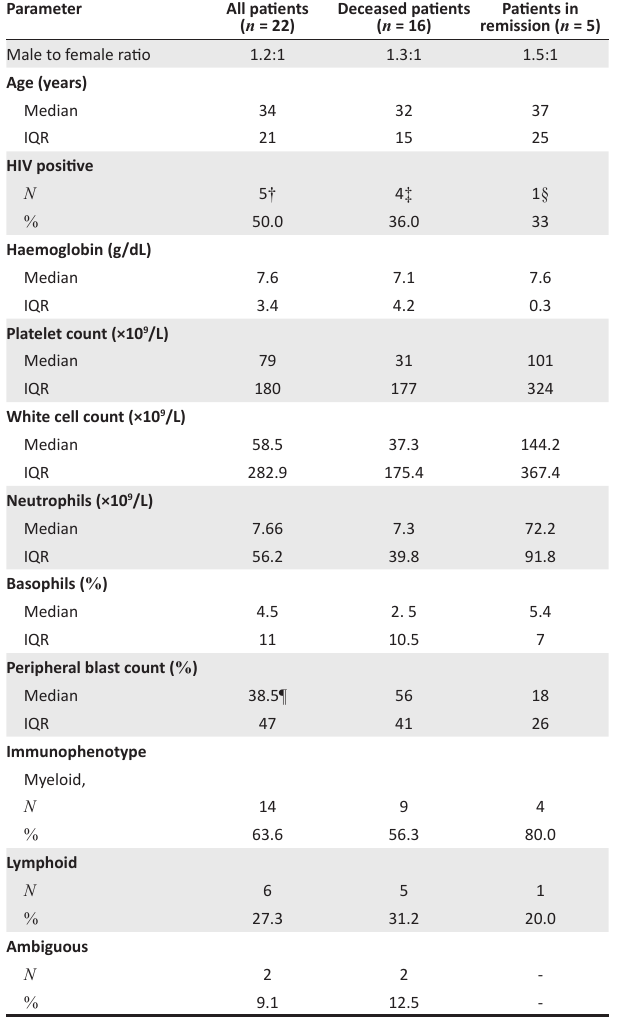
TABLE 1: Demographic and laboratory information for patients with CML in blast phase, Johannesburg, South Africa, 08 April 2016 to 16 October 2019. Parameter